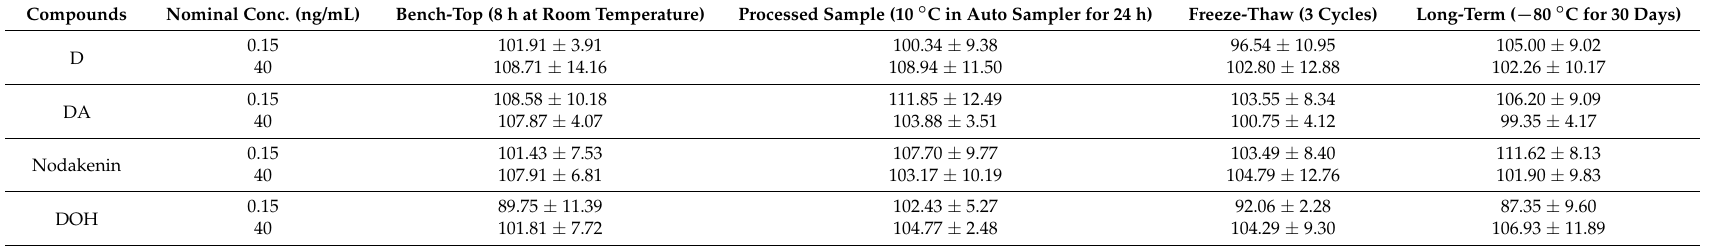
Table 2. Stability of D, DA, nodakenin, and DOH in human plasma under various storage